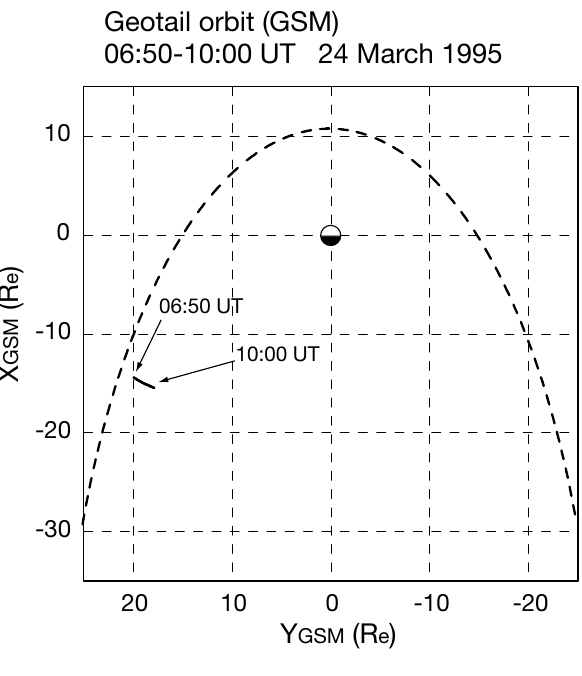
Fig. 2. Projection onto the GSM- XY plane of the Geotail orbit between 06:50–10:00 UT on 24 March 1995. A dotted curve in the figure corresponds to the averaged location of the magnetopause calculated with a model by Roelof and Sibeck